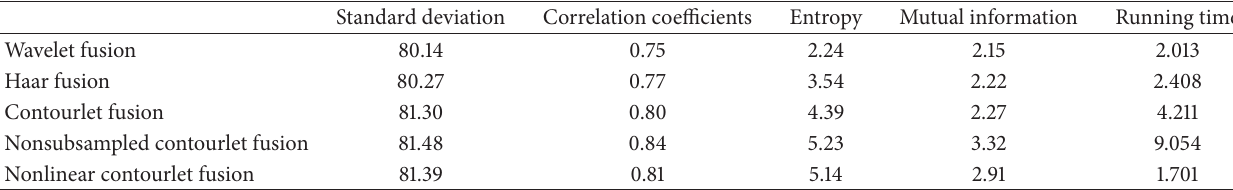
Table 4: Index of performance evaluation.